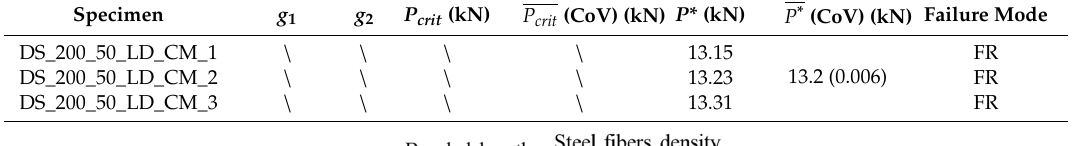
Table 4. Test results of steel-reinforced grout (SRG)-concrete joints